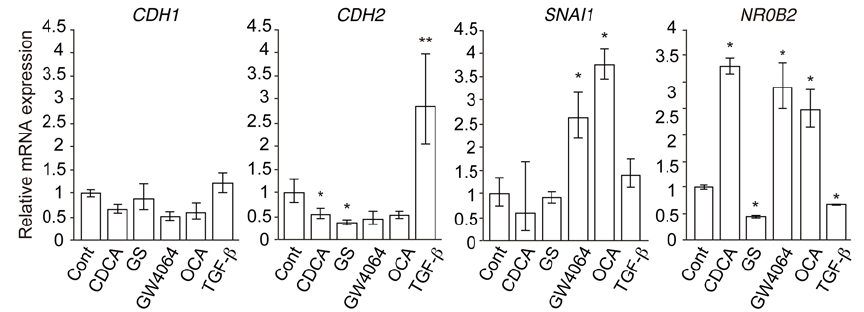
Figure 3. Expression of epithelial–mesenchymal transition (EMT)-related genes and the FXR target gene NR0B2 in HuH-7 cells. Cells were treated with vehicle control (Cont), 100 μM CDCA, 32 μM GS, 10 μM GW4064, 10 μM OCA, or 10 ng/mL TGF-β for 48 h. * p < 0.05; ** p < 0.01 versus Cont.